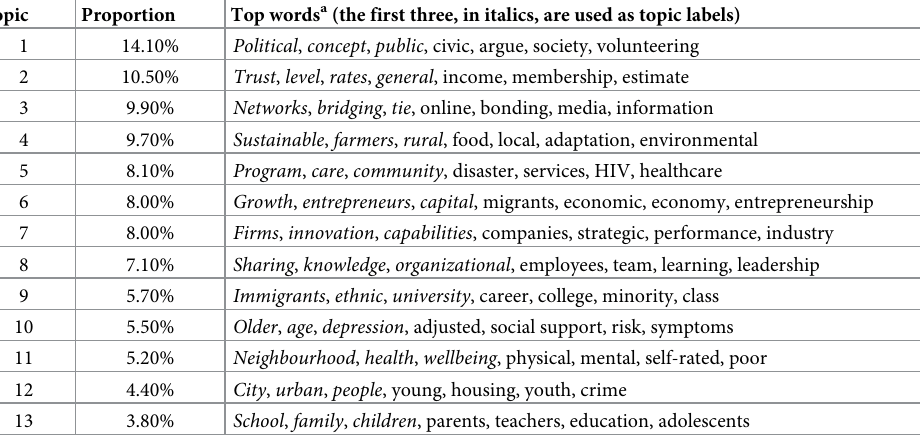
Table 1. Presentation of the topics identified by our model. Topic Proportion Top words a (the first three, in italics, are used as topic